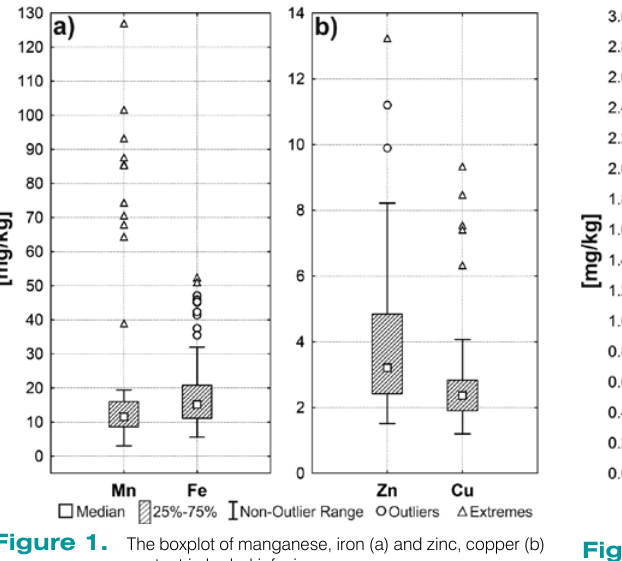
Figure 2. The boxplot of nickel, chromium (a) and lead, cadmium (b) content in herbal